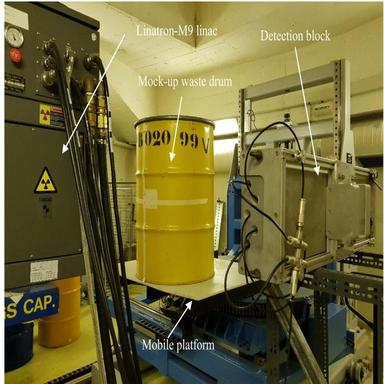
Overview of the experimental setup at the SAPHIR platform (CEA Paris-Saclay).